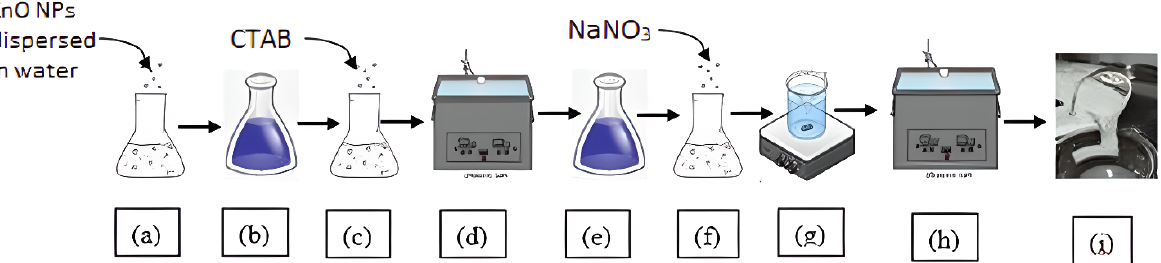
Figure 3. Process of preparation of type2 viscoelastic fluid with nanoparticle additives; Steps ( a – d ) show the process for preparation of surfactant nanofluid solution and steps ( e – i ) depict the process of formation of SBVEF; steps ( d , h ) show ultrasonication process and step ( g ) shows magnetic stirring.